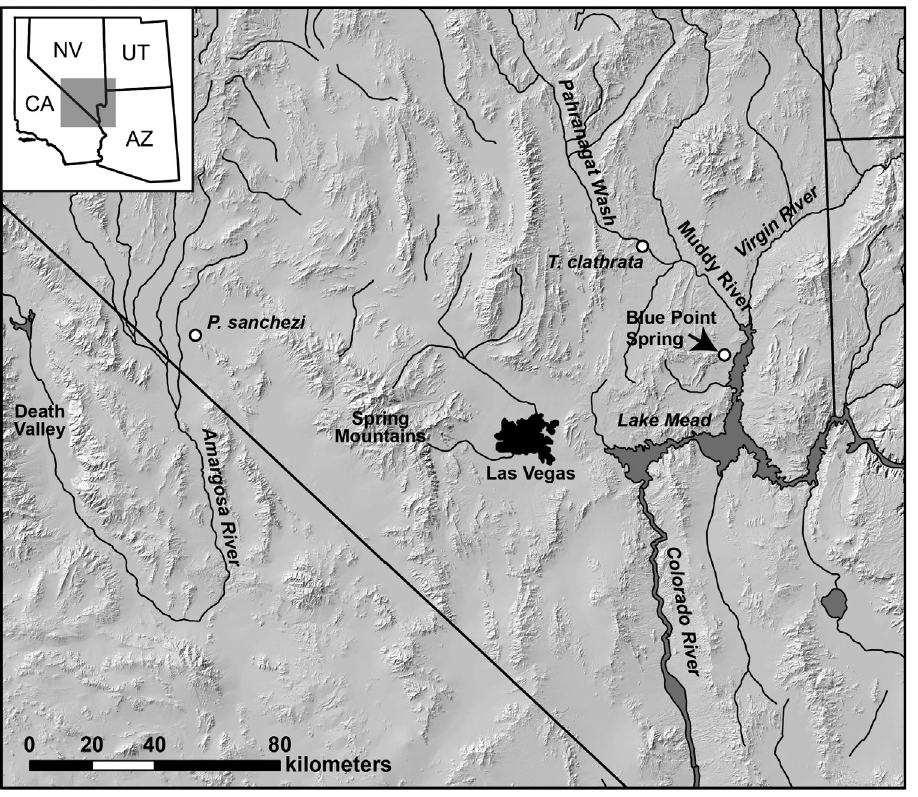
Figure 1. Map showing the location of Blue Point Spring relative to other geographic areas discussed in the text. The collecting localities for specimens of Pyrgulopsis sanchezi and Tryonia clathrata (sister taxa of Blue Point Spring endemics) used in the molecular phylogenetic analyses are also